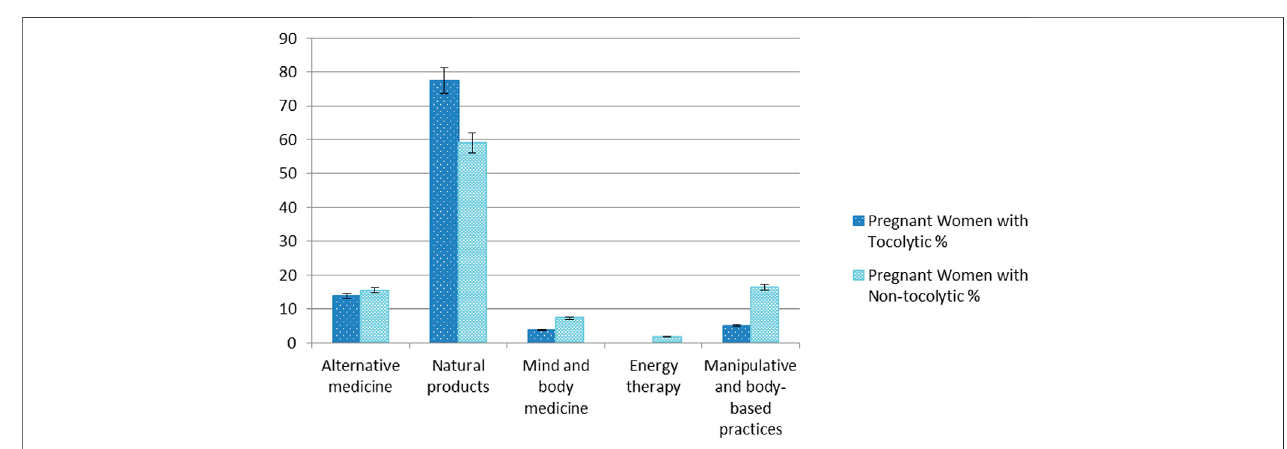
FIGURE 1 | Types of complementary medicine used by pregnant women receiving tocolytic and non-tocolytic treatment.